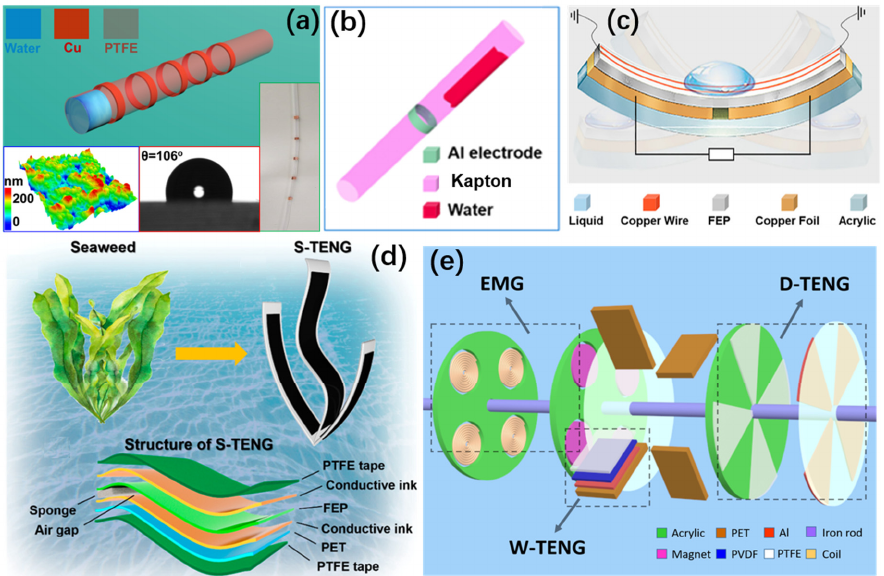
Figure 4. ( a ) Schematic diagram of the tube-based TENG (reproduced with permission from [124]. Copyright 2018 Elsevier Ltd., Singapore). ( b ) Schematic diagram of the TENG (reproduced